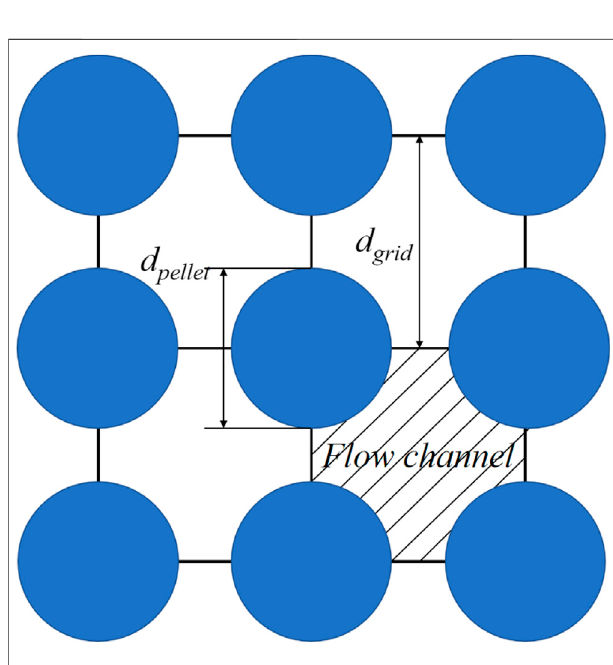
FIGURE 2 | Geometry of